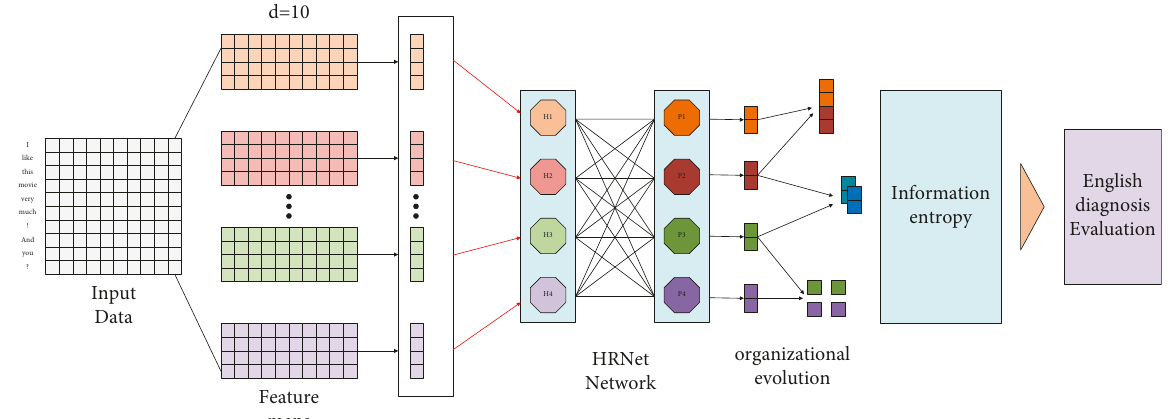
Figure 1: Structure diagram of the English diagnostic intelligence evaluation model.